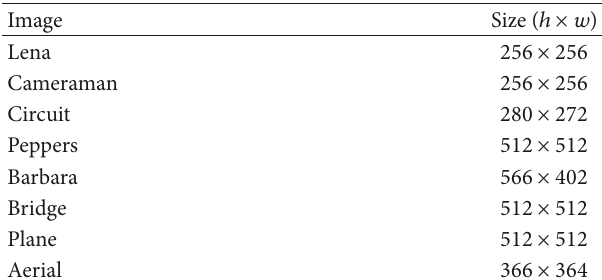
Table 5: Testing